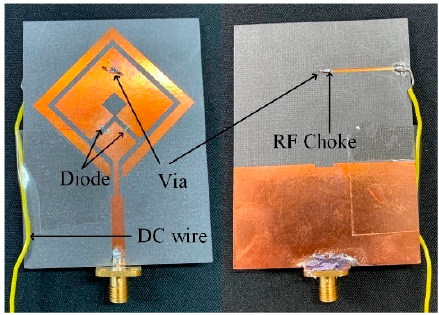
Figure 9. Photograph of fabricated antenna.